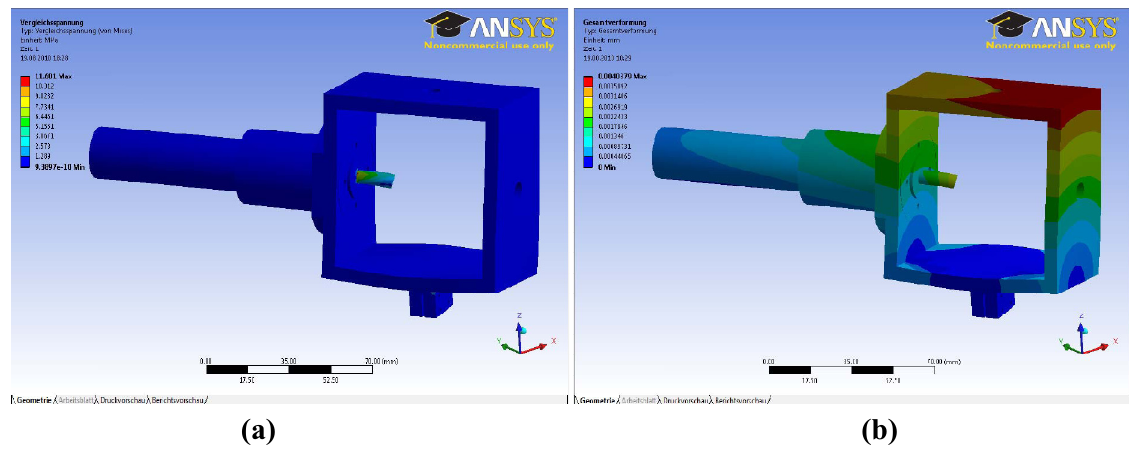
Figure 8. (a) Von Mises stress analysis. (b) Deformational analysis.